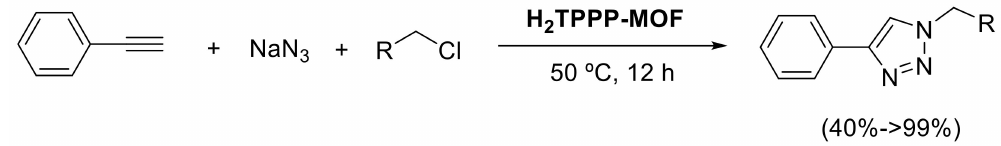
Figure 14. Structure of 5,10,15,20-tetrakis(4-(3-(pyrazin-2-yl)-1 H -pyrazo-1-yl)phenyl)porphyrin ( H 2 TPPP ).